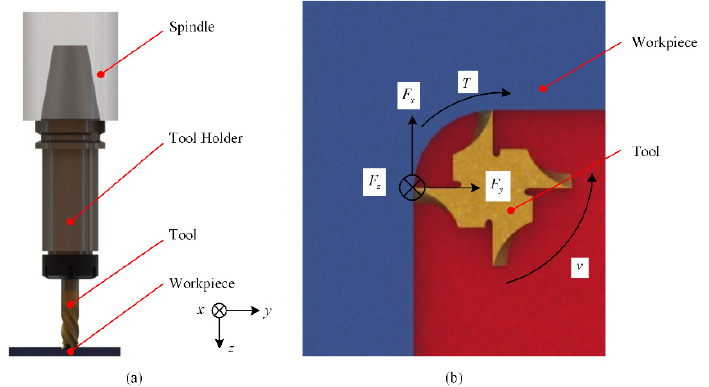
Figure 2. ( a ) composition of the cutting system; ( b ) cutting force on tool tip.